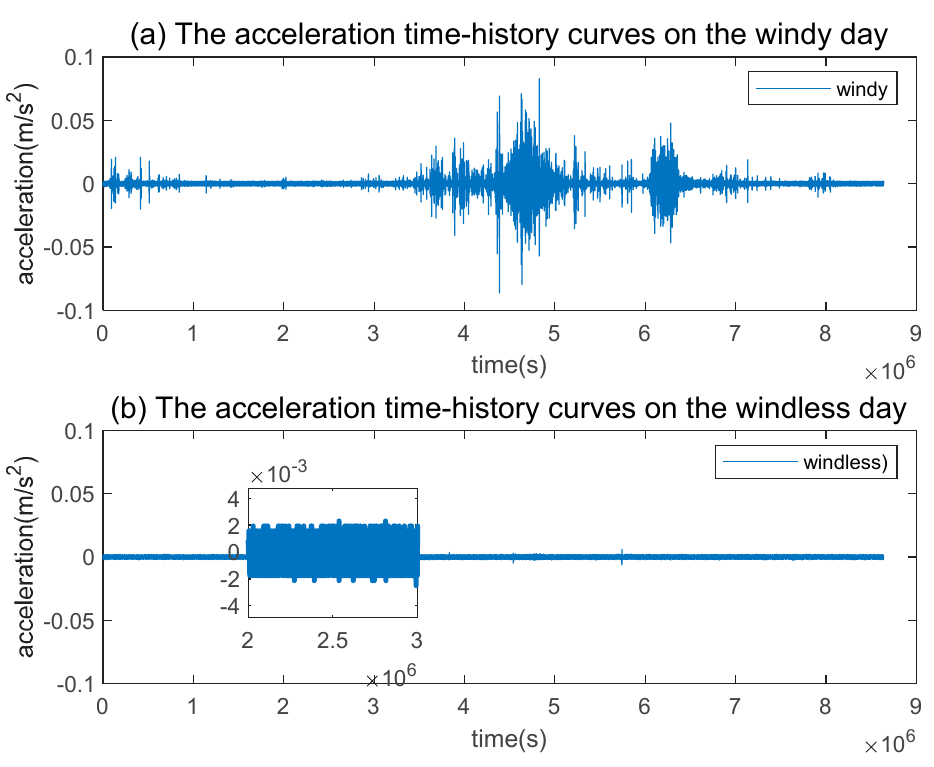
Figure 6. Comparison of acceleration time-history curves on windy and windless day.